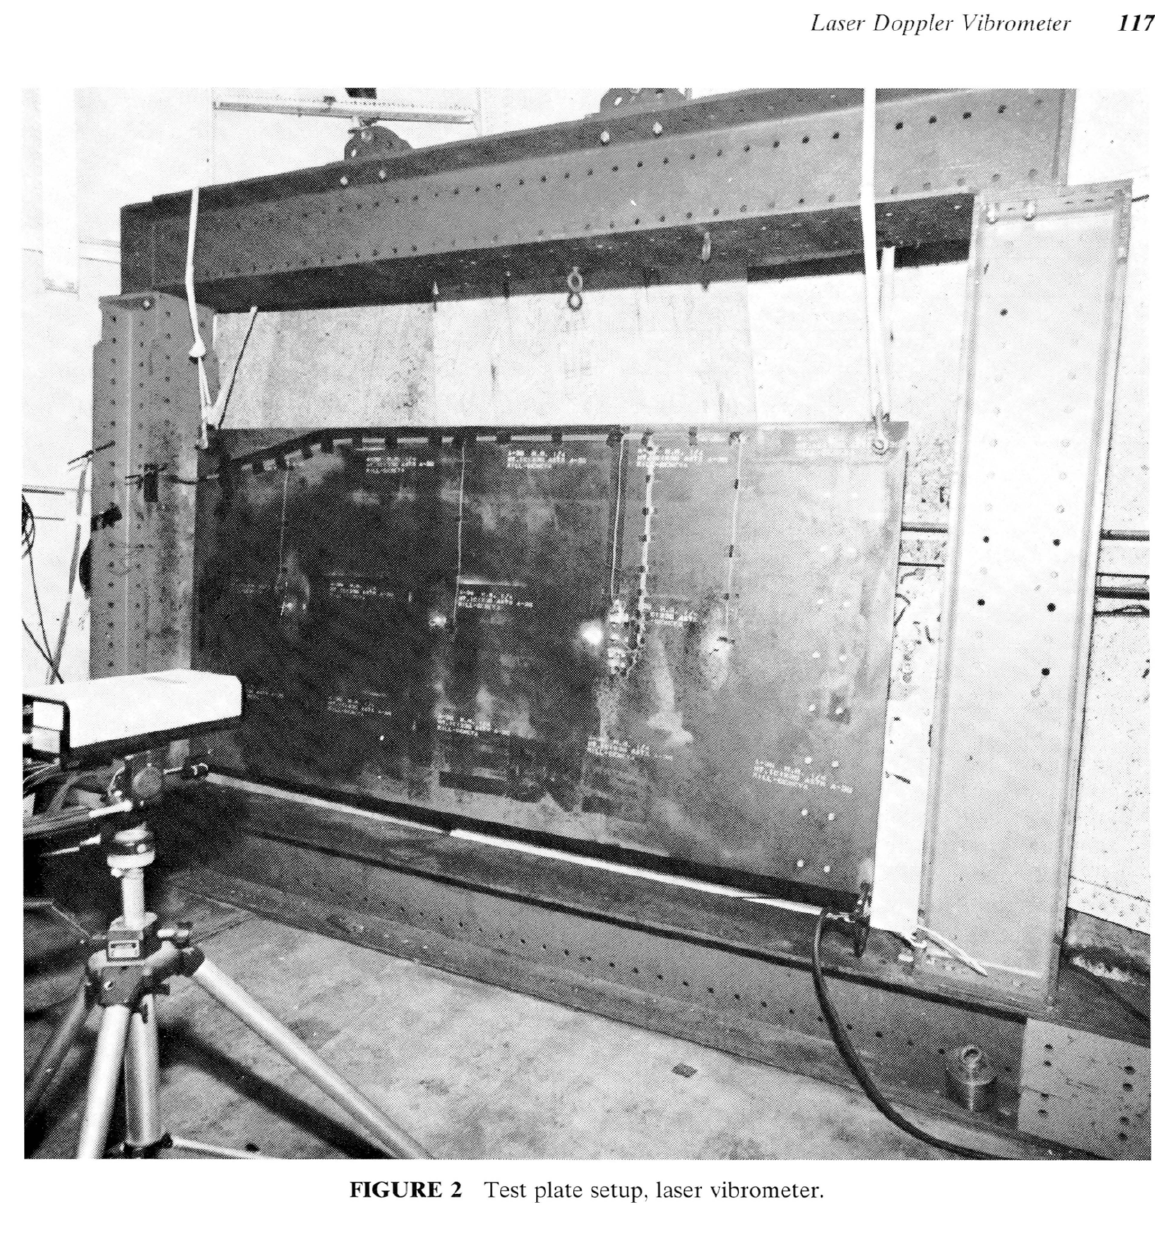
FIGURE 2 Test plate setup, laser